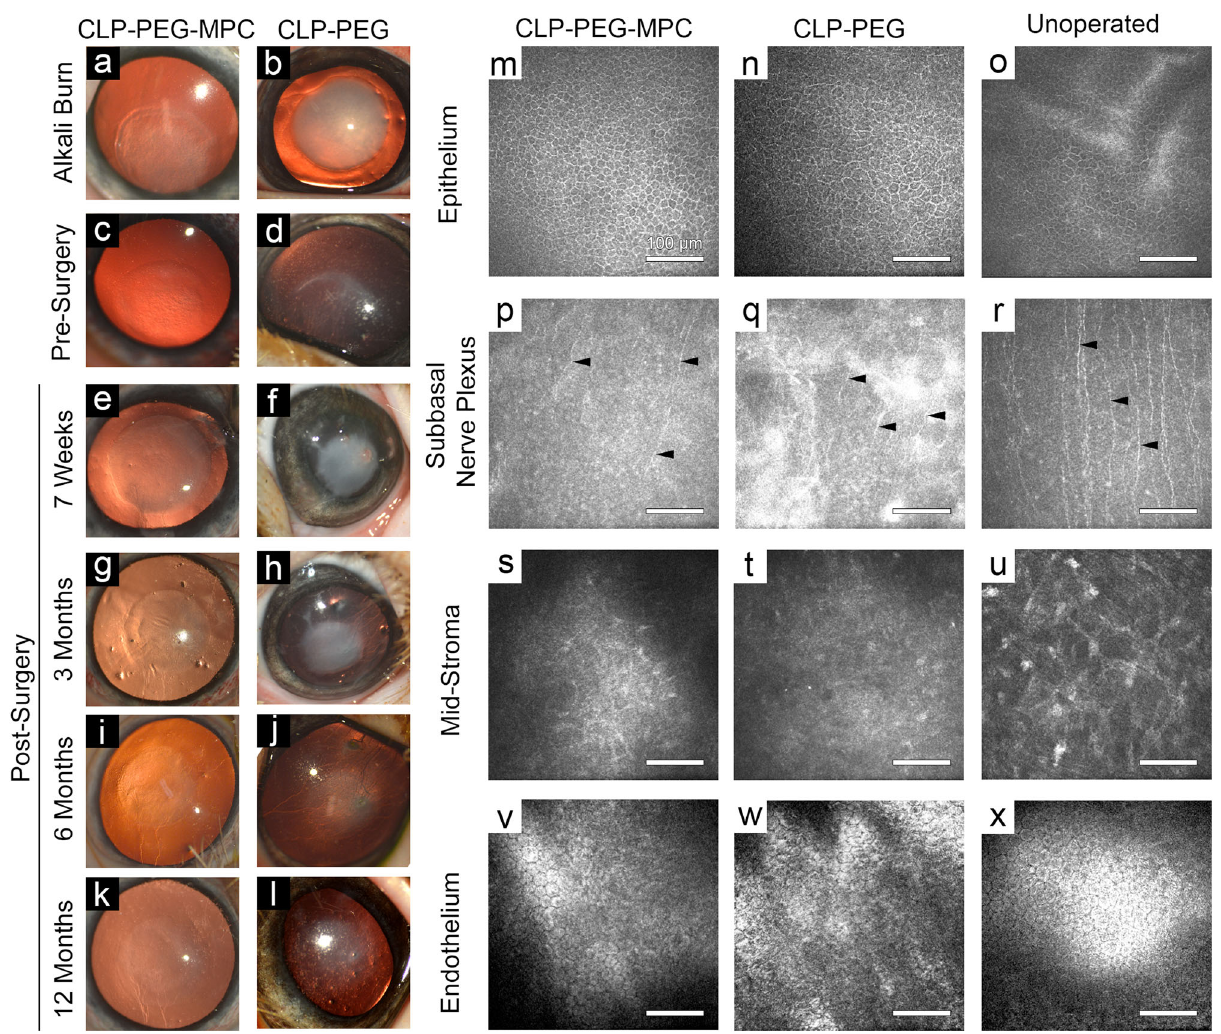
Fig. 3 CLP-PEG-MPC implants in alkali burned mini-pig corneas compared to CLP-PEG only implants. a – l Surgical progression of CLP-PEG-MPC hydrogels compared to CLP-PEG hydrogels implanted in mini-pig corneas following alkali burns. Corneal haze was seen immediately after the alkali burn to the central cornea ( a , b ) and is still present just before surgery ( c , d ). After surgery, haze is present up to 6 months ( e – j ) and is decreased by 12 months post-operation ( k – l ). m – u In vivo confocal microscopy of the regenerated CLP-PEG-MPC and CLP-PEG neo-corneas at 12 months post-operation in comparison to unoperated corneas, showing regeneration of corneal epithelium, subepithelial nerves (arrowheads) and stroma. The unoperated endothelium ( v – x ) remains intact. White scale bars, 100 µ